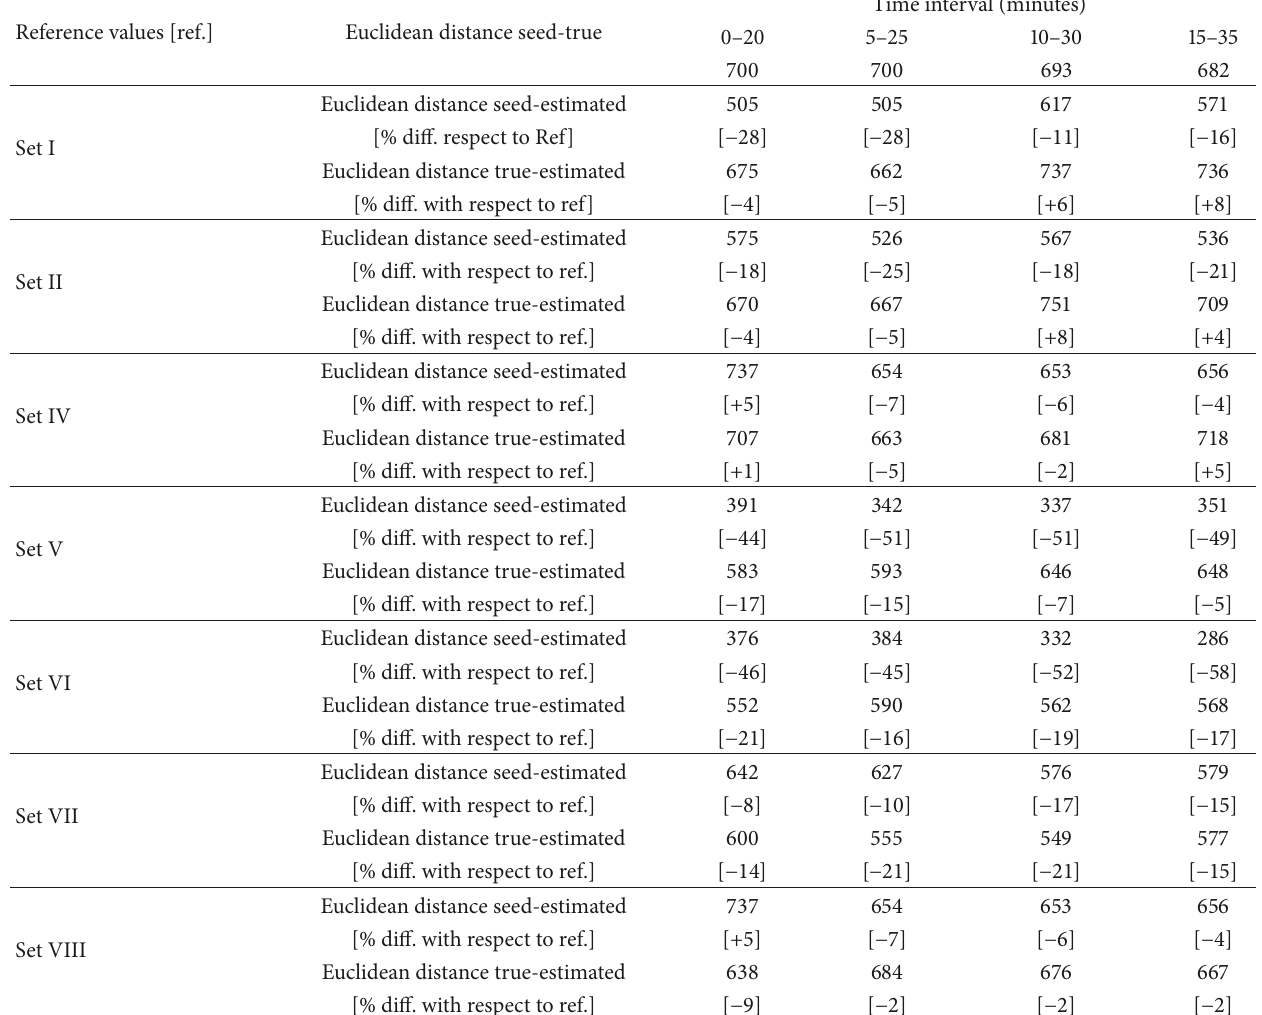
Table 7: Evaluation of the estimated demand in terms of O–D aggregated distribution in time. Reference values